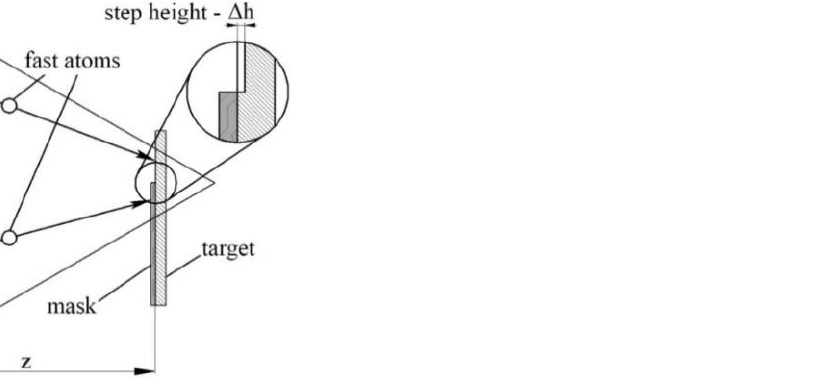
( b ) Figure 8. Photographs of the accelerating grid and 3-mm-diameter end mill on the rotating holder ( a ) as well as the accelerating grid immersed in plasma and generating a fast atom beam ( b ). The results of the mills etching are presented in Table 2. They show that at the begin- ning, for the sections distanced from the mill end at 7 mm, the etching rate is maximum and amounts to 3 μ m/h. Further on, the etching rate falls down, and after a 3-h-long etching, it is close to zero for the section distant from the mill end at 7 mm and to 0.2 μ m/h for the sections distant from the mill end at 2 and 12 mm. Table 2. Cutting edge radii after etching the end mills. Etching Time Cutting Edge Radius (μm ) for the Section Distant from the Mill end at 2 mm (A)